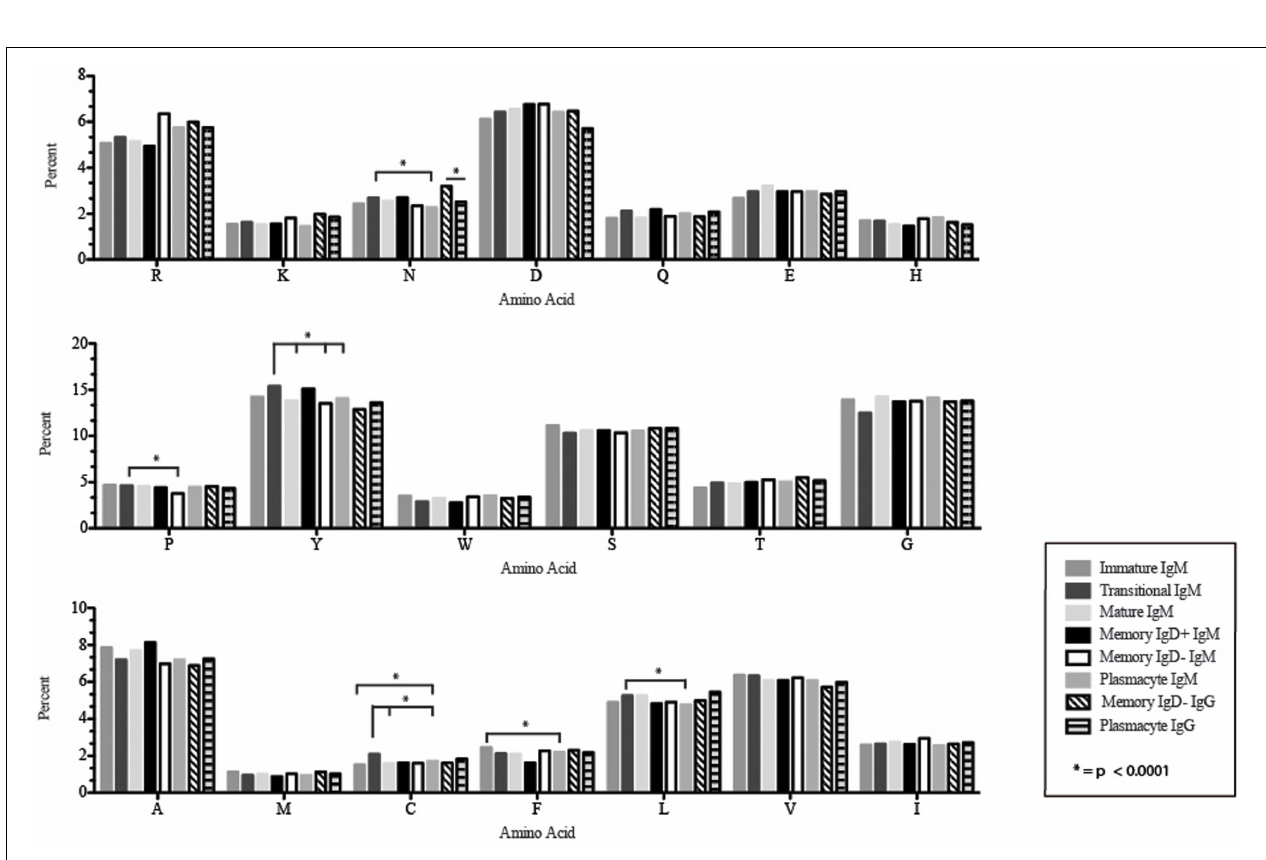
FIGURE 7 | J H usage in Ig µ and Ig γ transcripts from selected B cell populations in the blood of a normal, healthy human. The percent of sequences using J H 1 through J H 6 among in-frame reads cloned from the peripheral blood from immature, transitional, mature, memory IgD + , memory